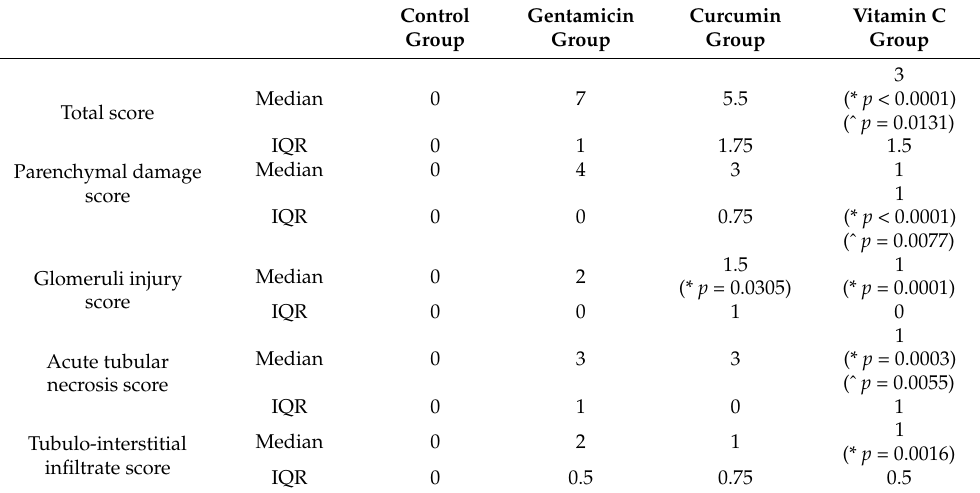
Table 3. Histological scores of renal